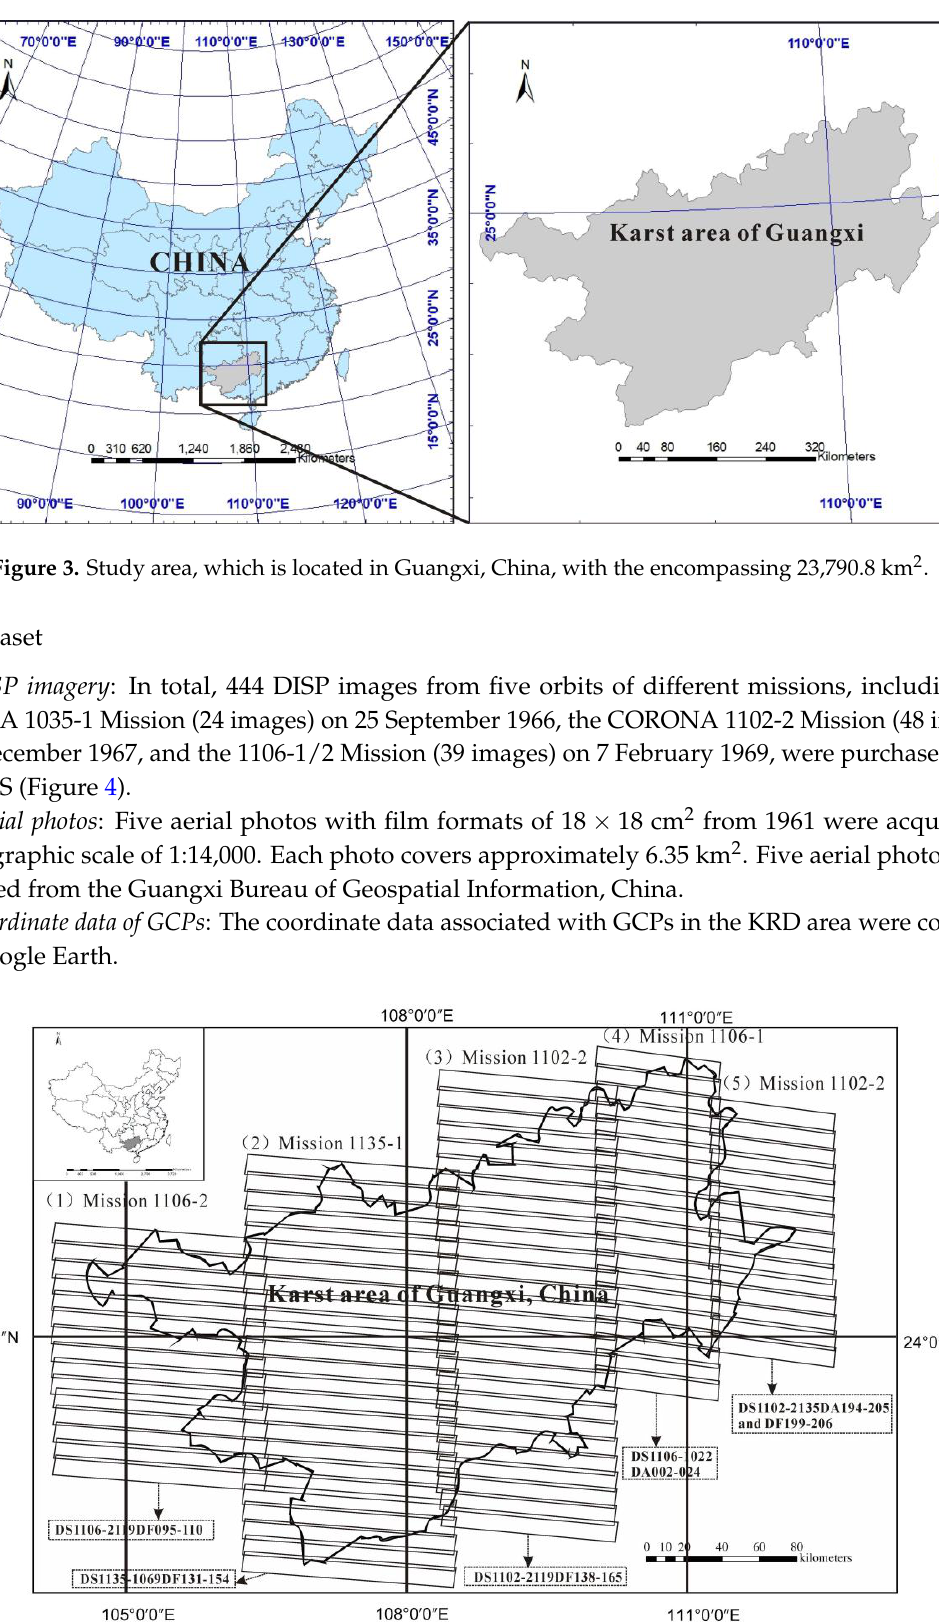
Figure 4. DISP image dataset (There are 444 DISP images from five orbits of different missions covering the whole study area).